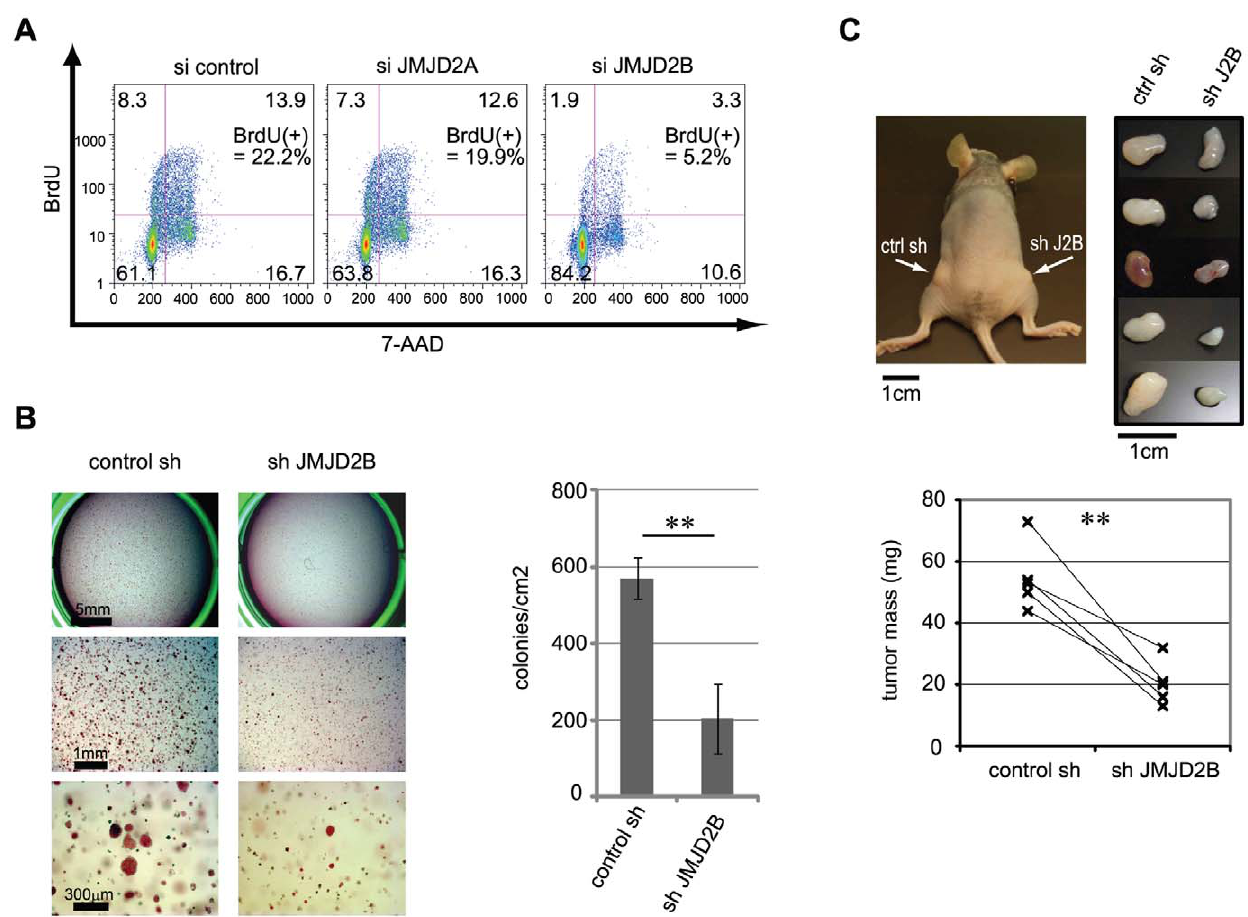
Figure 2. JMJD2B positively regulates the proliferation of ER-positive breast cancer cells. (A) JMJD2B knockdown impairs proliferation. T- 47D cells were transfected with either control siRNA or siRNA against JMJD2A or JMJD2B, cultured for 72 hr, pulsed for 1 hr with BrdU, stained with APC-conjugated anti-BrdU antibody and 7-AAD, and analyzed by flow cytometry. Results are representative of four independent trials. (B) JMJD2B knockdown impairs colony formation. Single cell suspensions of ZR-75-1 cells expressing control shRNA or shRNA against JMJD2B were seeded in soft agar. After 14 days, colonies were stained with crystal violet and microscopic fields were photographed (left). The number of colonies/cm 2 was determined (right). Data represent the colony density of three wells (mean 6 s.d). **p , 0.01. Representative data of three independent trials. See also Figure S2. (C) JMJD2B knockdown impairs tumor formation in xenograft model. Upper left: tumors (indicated by arrows) in a representative NIH-III mouse injected with control ZR-75-1 cells on the left flank and JMJD2B-depleted ZR-75-1 cells on the right flank. Upper right: dissected tumors from nude mice. Lower: mass of tumors is shown. **p , 0.01.